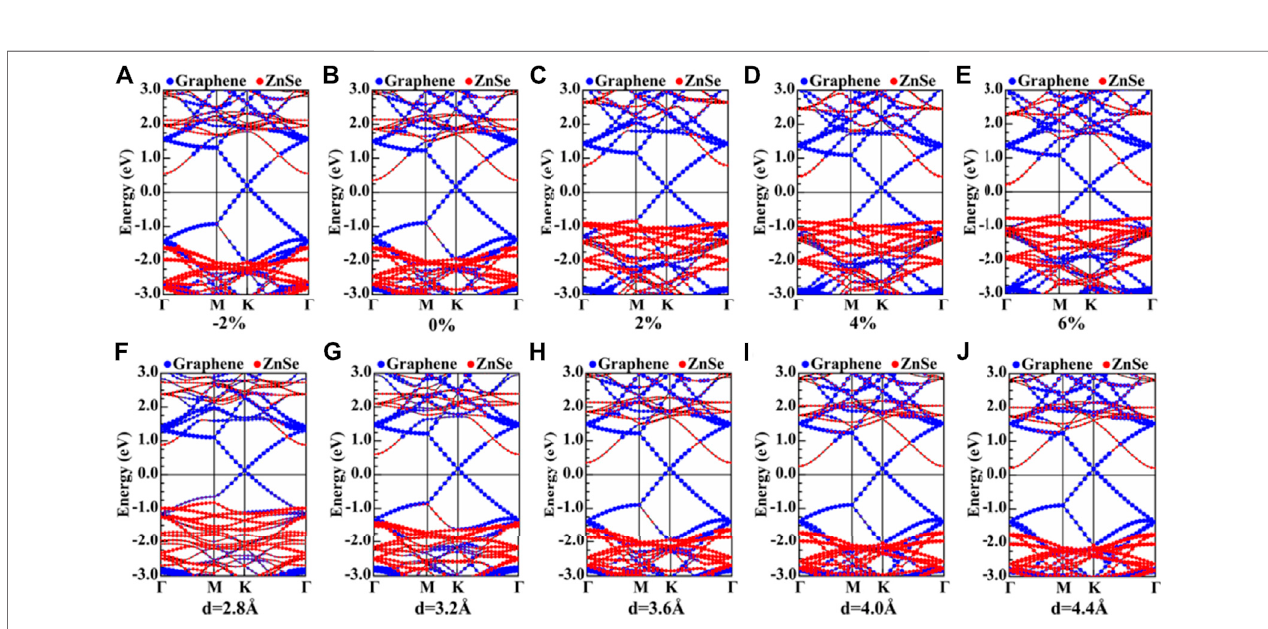
FIGURE 4 | (A – E) Projected band structures of the graphene/ZnSe heterojunction under horizontal strain. (F – J) Projected band structures of the graphene/ZnSe heterojunction under vertical strain.